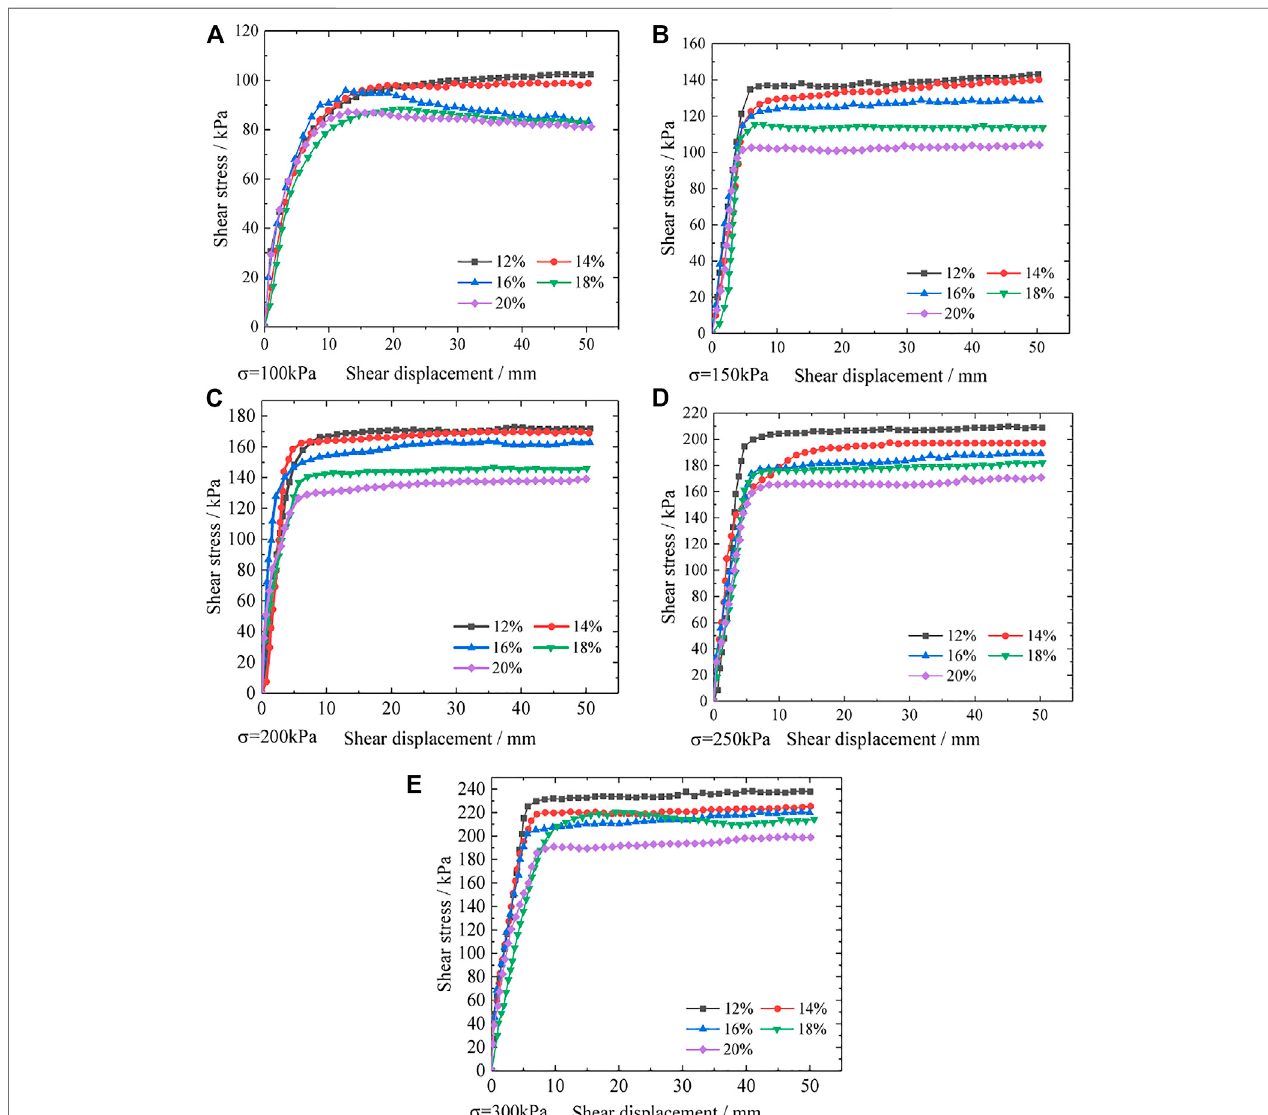
FIGURE7| Therelationshipcurveofshearstress-sheardisplacementofsamplewithmoisturecontent. (A) Normalstressis100kPa (B) Normalstressis150kPa; (C) Normal stress is 200 kPa; (D) Normal stress is 250 kPa; (E) Normal stress is 300 kPa.